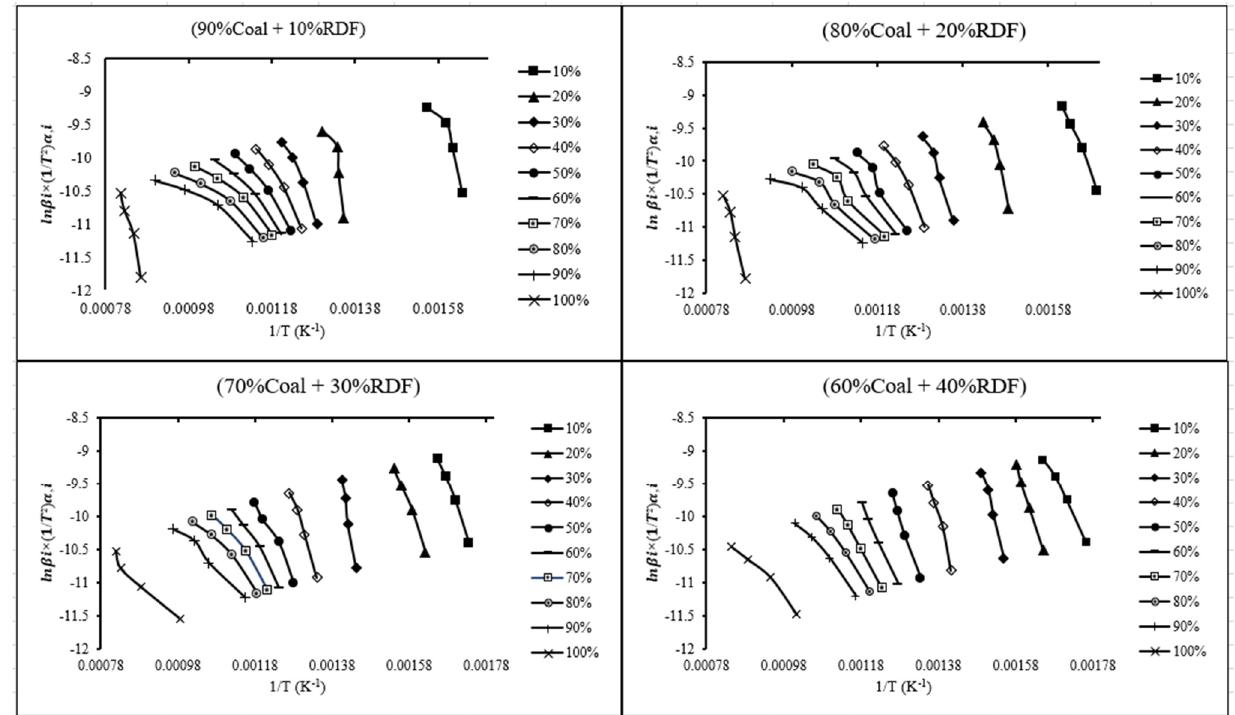
Figure 3 . Plots for kinetic model, FWO for various blends of coal/RDF .